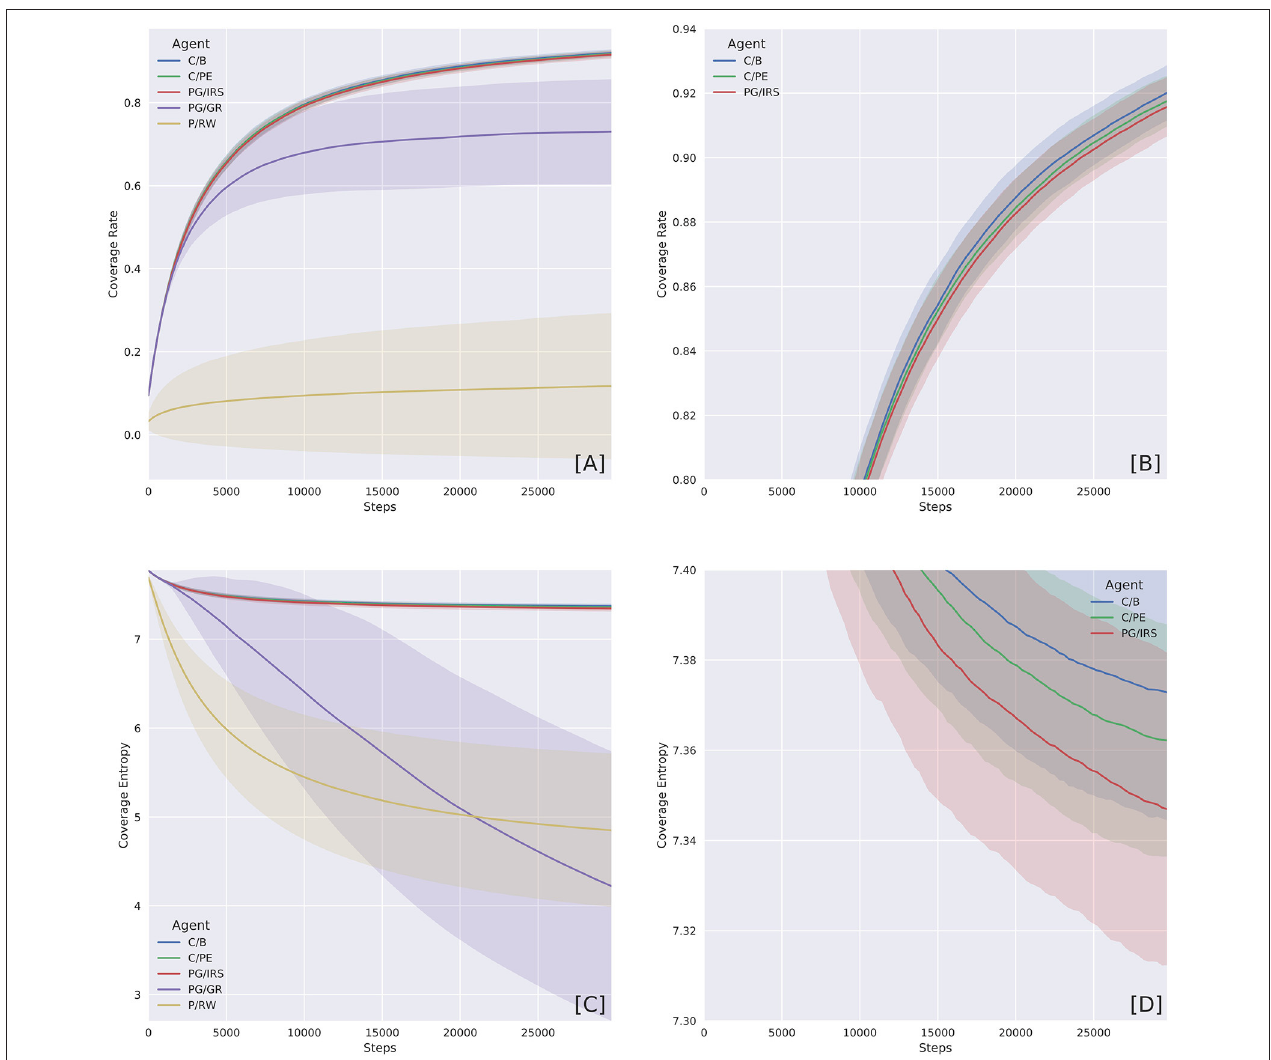
FIGURE 3 | Coverage Rate (CR) and Coverage Entropy (CE) by agent variants. The two measures were computed by first turning the state space into a 50 × 50 grid, ignoring velocities. CR then marks over time whether or not a cell has been visited. Whereas, CE treats the grid as a probability distribution. Starting with maximum entropy, CR cumulatively counts the number of times a position is being visited. Entropy was calculated at each time step using the normalized counter. (A) Overview of CR shows the distinction between curious and non-curious agents. Curiosity caused the agents to explore faster. (B) Close-up on the curious agent variants, which were equally explorative. (C) Overview of CE shows agents with different levels of perseverance. The P/RW variants were captured by the attractor, whilst the PG/GR variants were prone to blockage. (D) Close-up on curious agents, which were characterized by higher CE due to attractor avoidance and more frequent repeller visitation attempts. Shaded regions represent one standard